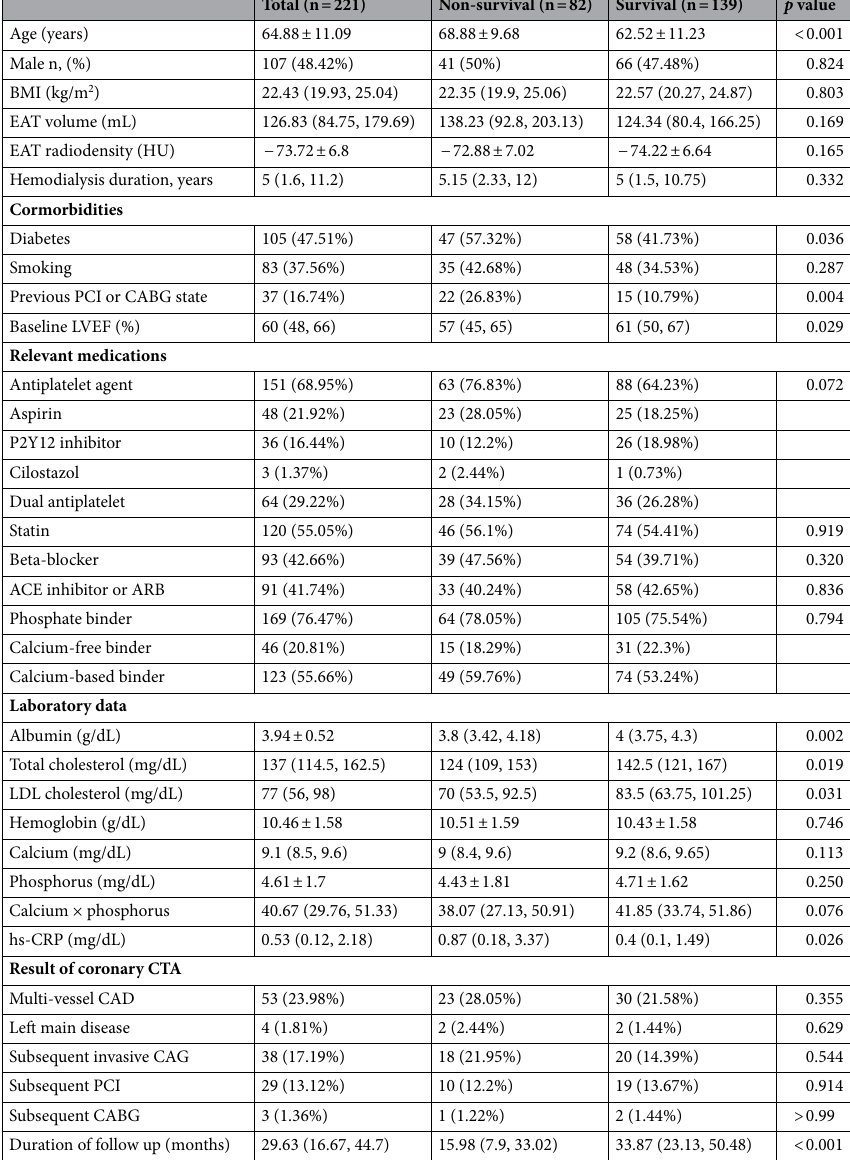
Table 1. Baseline characteristics of patients with ESRD according to all-cause mortality. ACE angiotensin converting enzyme, ARB Angiotensin II receptor blocker, BMI body mass index, CABG coronary artery bypass graft, CAD coronary artery disease, CTA CT angiography, EAT epicardial adipose tissue, ESRD end-stage renal disease, HDL density lipoprotein, hs-CRP high sensitivity C-reactive protein, HU hounsfield unit,